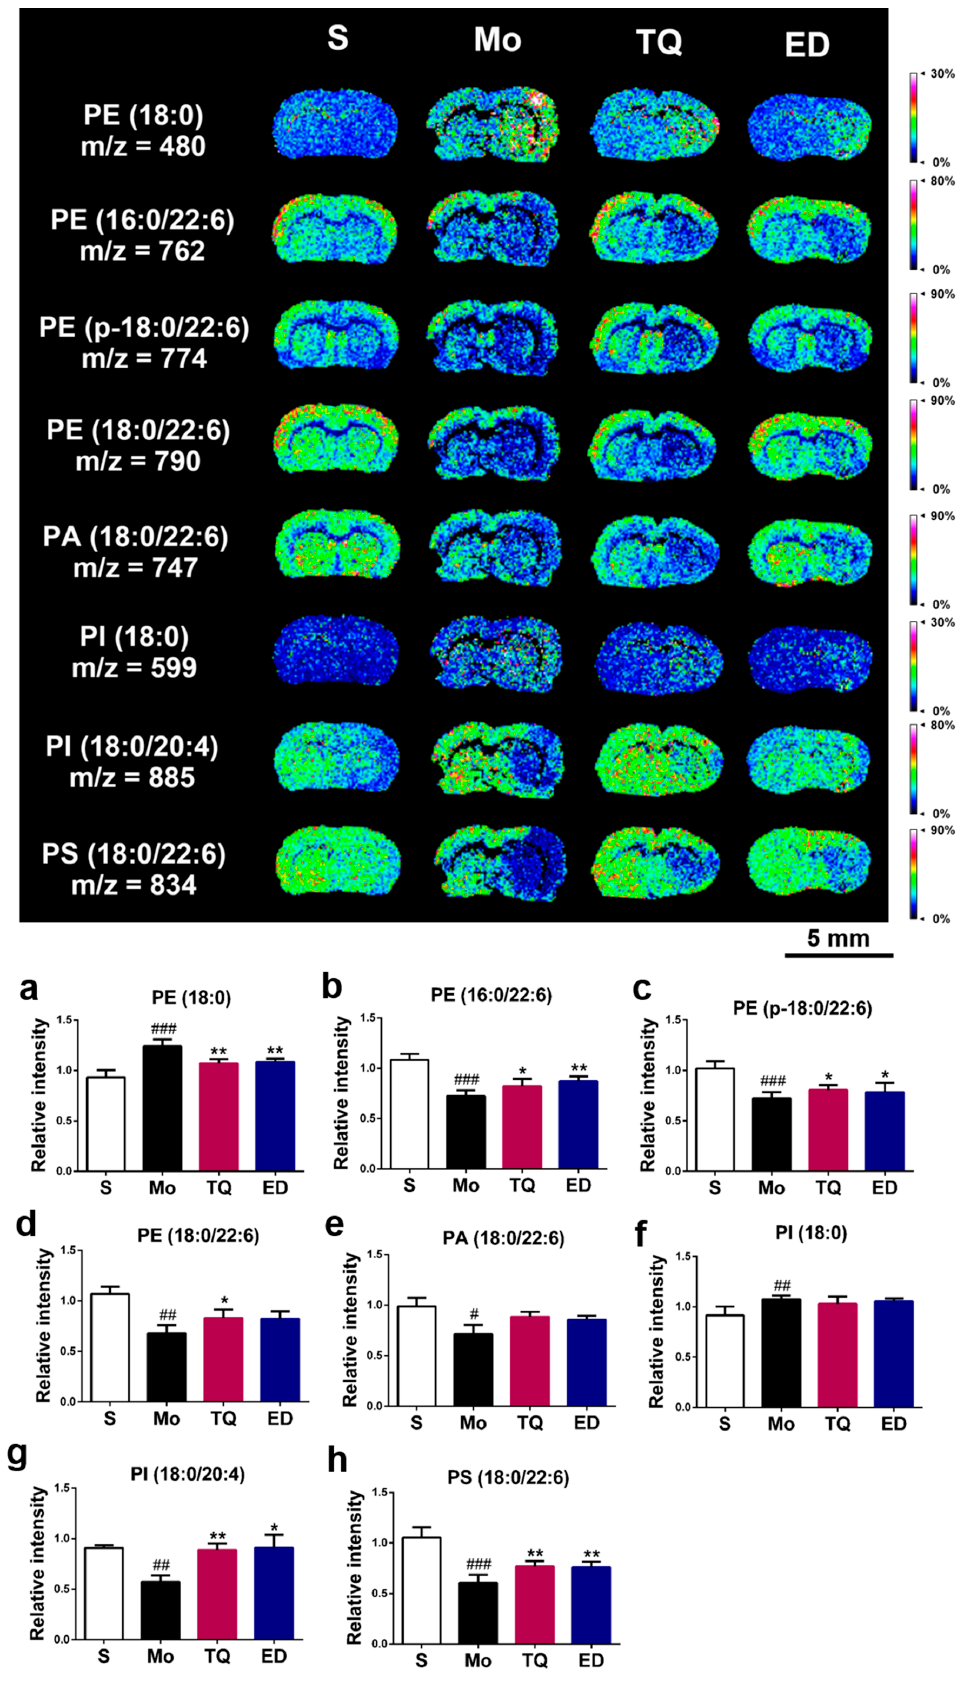
Figure 5. In situ matrix-assisted laser desorption ionization mass spectrometry imaging